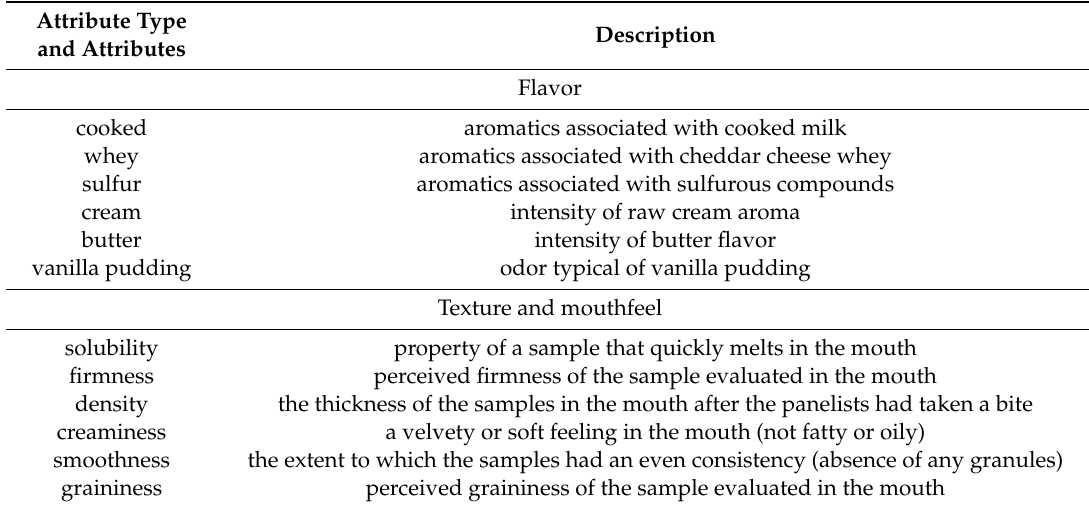
Table 1. Sensory attributes and description used to characterize the probiotic yogurt with polymerized whey protein (PWP).